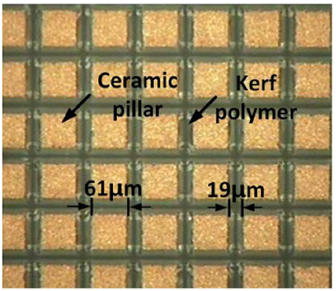
Figure 5. A photograph of the fabricated 1-3 piezo-composite.